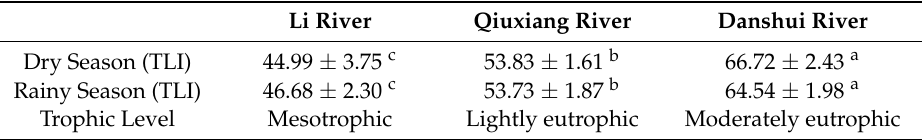
Table 2. The trophic level index and trophic level of the three tributaries.